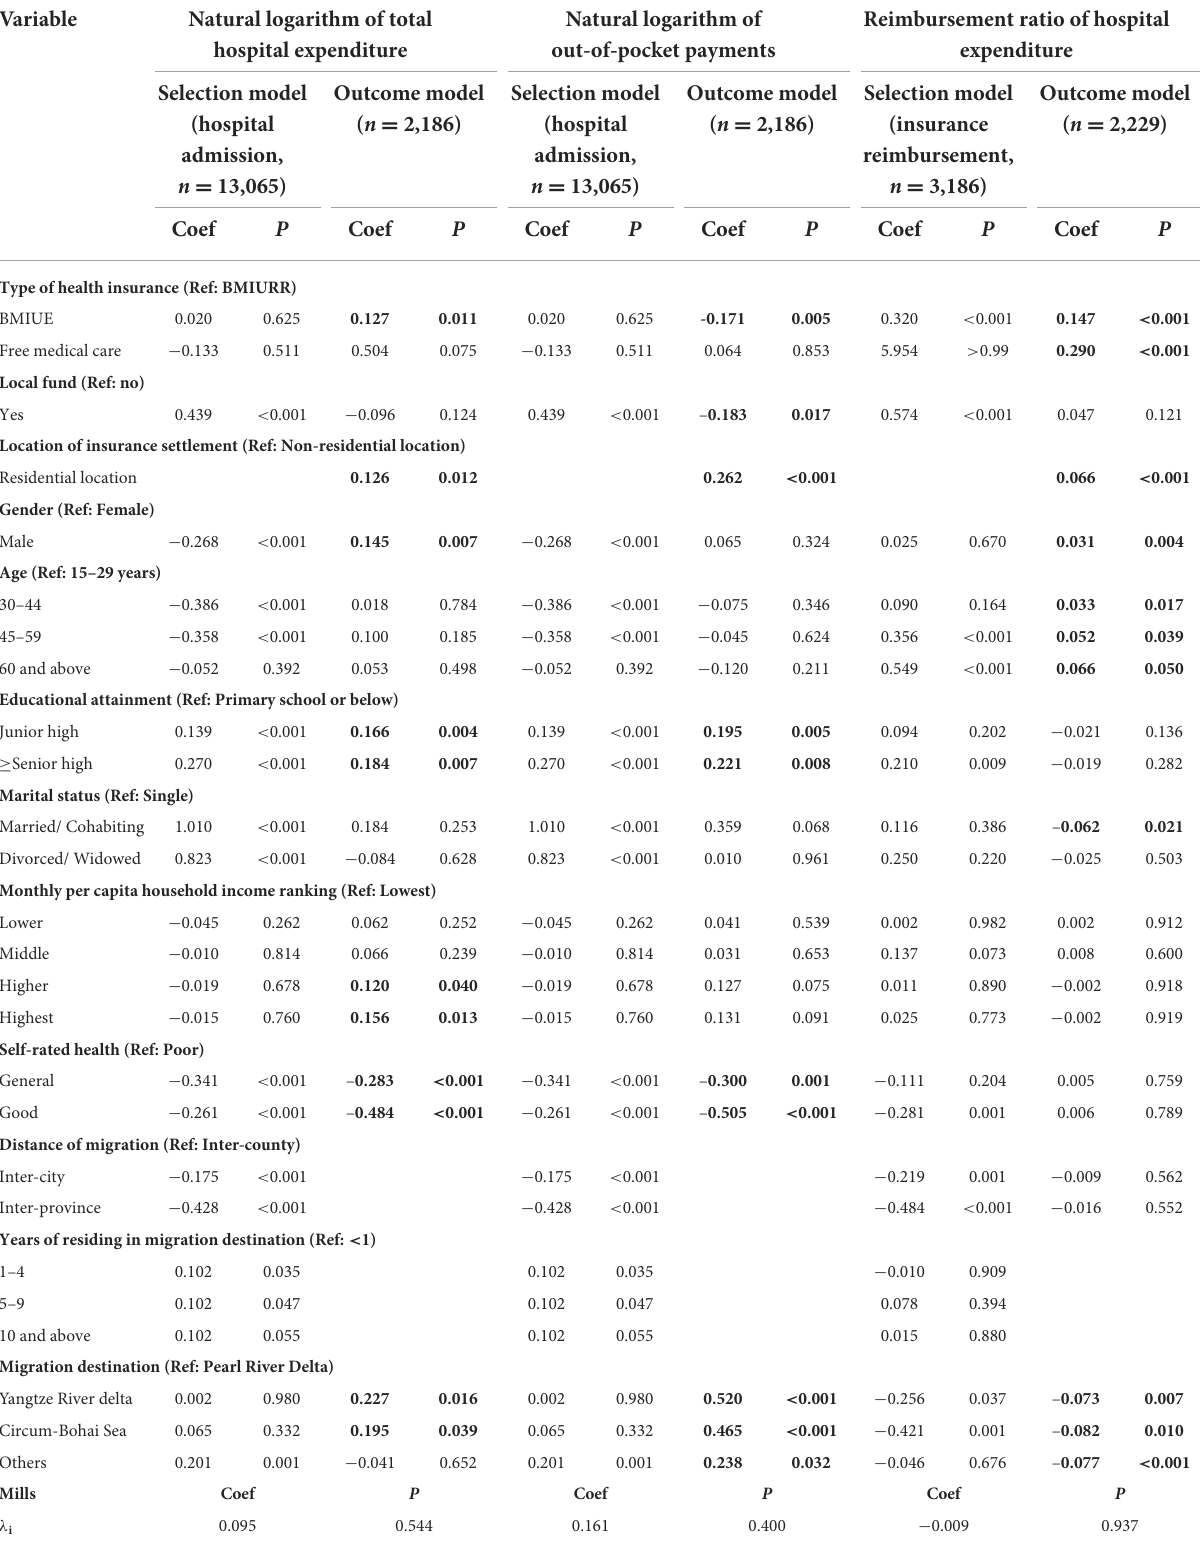
TABLE 5 The effect of health insurance: results of Heckman two-step model.